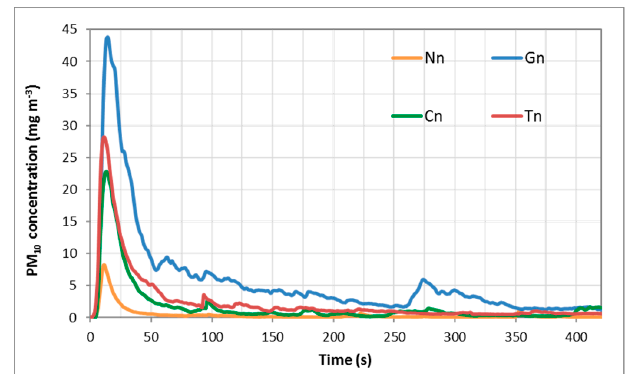
Figure 4. PM10 concentrations due to soil erosion and dust emission during the wind tunnel experiments in the land use areas: natural area (Nn), grazing (Gn), conventional agriculture practice (Cn), and traditional agriculture practice (Tn). (Data were taken from Swet and Katra, 2016 [11], and Katra et al., 2016 [3]).